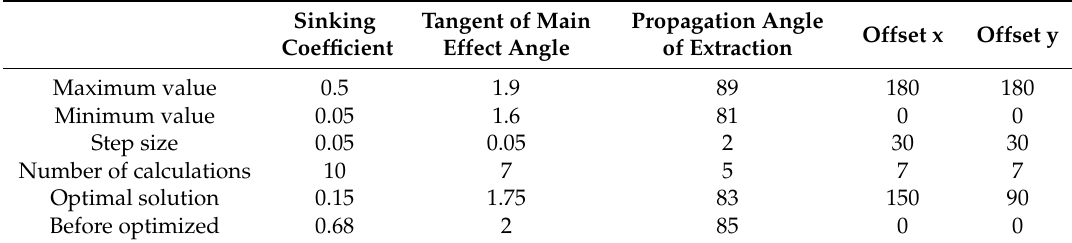
Table 3. Optimization of parameters that can be optimized